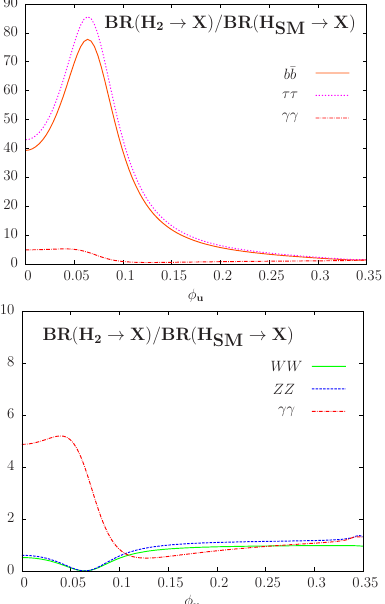
Figure 10. Upper panel: the ratio between the H 2 branching fractions in the C –NMSSM and the SM predictions for the same mass as a function of the phase φ u . Lower panel: the same but with a zoom on the small branching